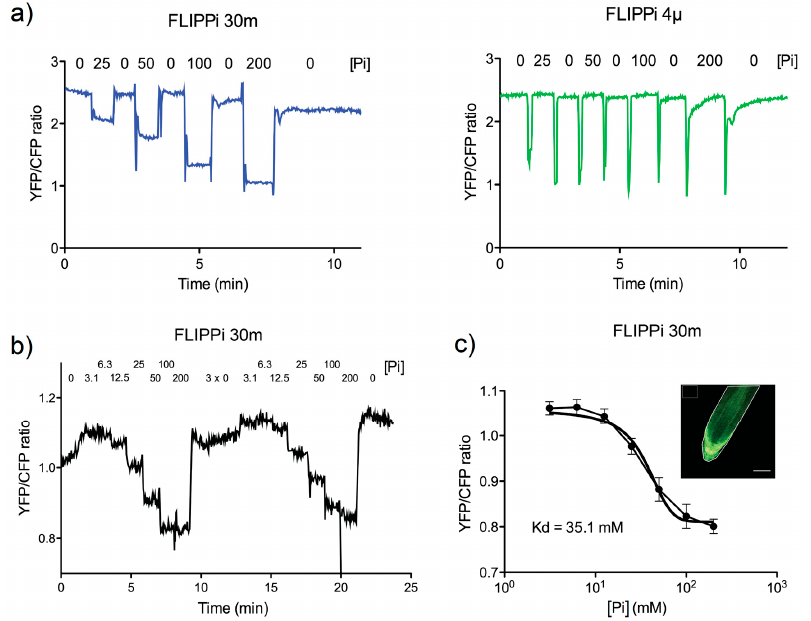
Figure 3. FRET response to Pi perfusions in roots of Arabidopsis FLIPPi sensor lines. ( a ) Time course of the e ff ect of a series of Pi bu ff er perfusions with increasing Pi concentration (25; 50; 100; 200 mM), alternated with perfusion with Pi-free bu ff er, on the FRET (YFP / CFP) emission ratio changes in roots from 8–12-day-old seedlings of Arabidopsis FLIPPi-30m and FLIPPi-4 µ lines. The analysis was performed with at least 3 independently transformed T3 homozygous FLIPPi-30m or FLIPPi-4 µ lines, with ca. 3 seedlings analyzed per line. ( b ) Time course of the e ff ect on FRET ratio changes of a series of Pi bu ff er perfusions with increasing Pi concentration (0; 3.1; 6.3; 12.5; 25; 50; 100; 200 mM) followed by perfusion with Pi-free bu ff er in roots of Arabidopsis FLIPPi-30m line. ( c ) Ligand-dependent FRET ratio change in response to Pi bu ff er solutions, calculated from (b). The curve and K d (mM) value were calculated with data points from each Pi concentration, corresponding to an average of ca. 10 YFP / CFP values. Top-right insert shows a CSLM overlay image of YFP / CFP channels with a seedling root used for perfusion analysis. The region of interest (ROI) measured in the analysis (covering the visible area of the root), and a ROI for background subtraction (square) are shown. Scale bar: 50 µ m. The YFP / CFP emission ratio was calculated by dividing average pixel intensities of ROIs from each